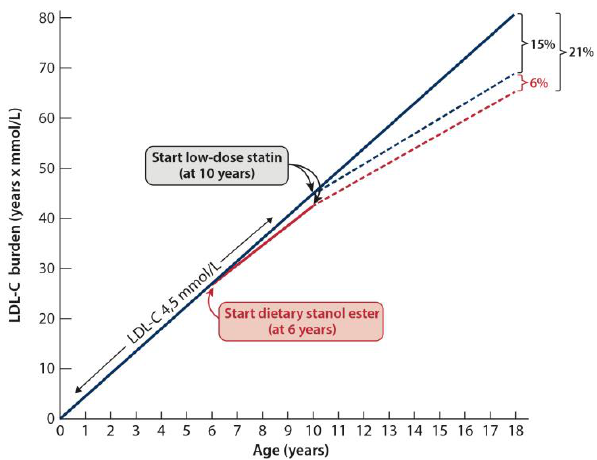
Figure 2. The cumulative low-density lipoprotein cholesterol (LDL-C) burden can be demonstrated by using the calculation = LDL-C levels × years of age [52]. To this end, we have used the data